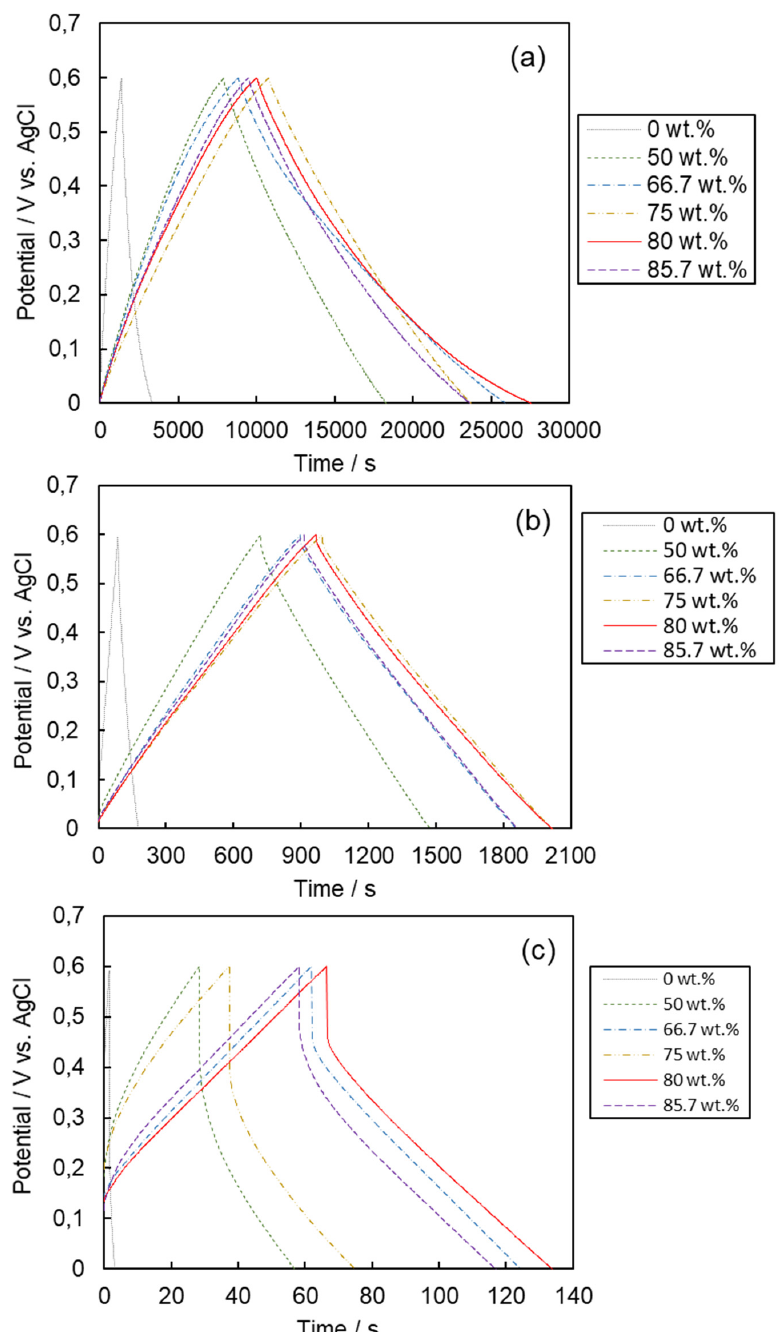
Figure 9. Charge–discharge data of the samples. At current density of ( a ) 10 mA g − 1 , ( b ) 100 mA g − 1 and ( c ) 1000 mA g − 1 .